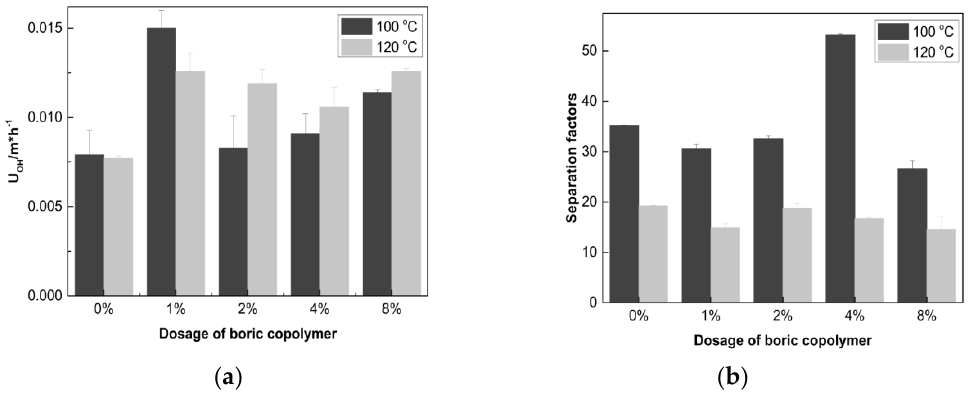
Figure 4. Diffusion dialysis (DD) results of composite membranes after heating at 100 °C and 120 °C, respectively. ( a ) Dialysis coefficient; ( b ) separation factors.